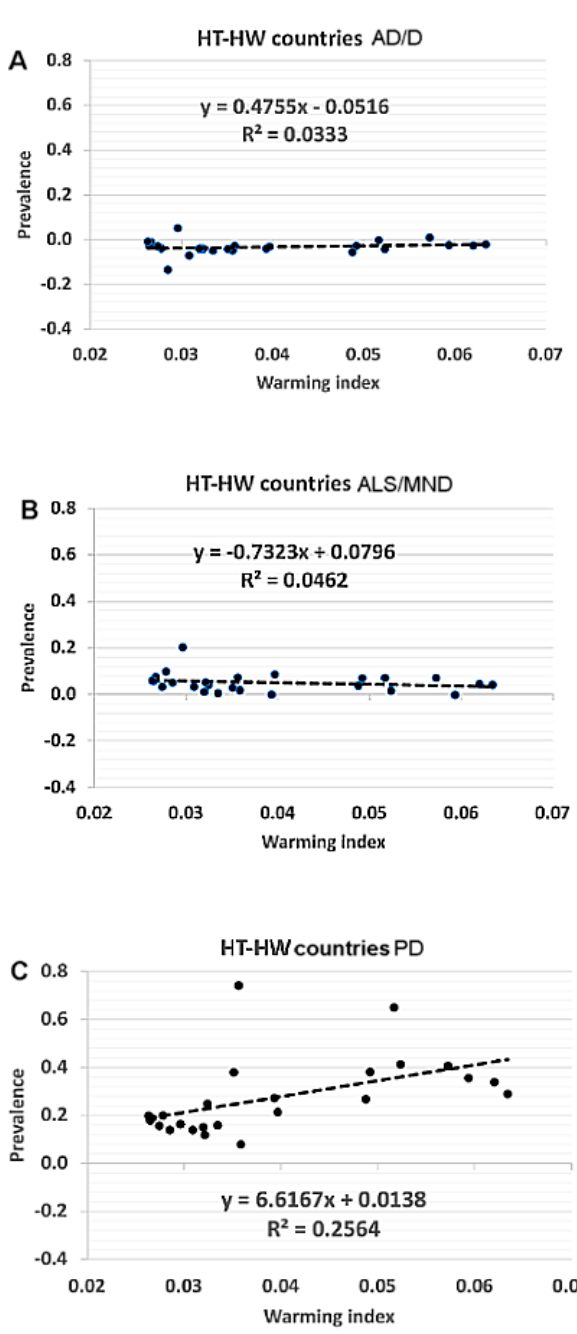
Figure 3. Scatter plots of prevalence and the warming index. Relationship between climate warming index WI1990–2016 variations in the HT-HW countries, and AD/D (panel A ), ALS/MND (panel B ) and PD (panel C ) prevalence. Each dot represents one of the 25 HT-HW countries considered.